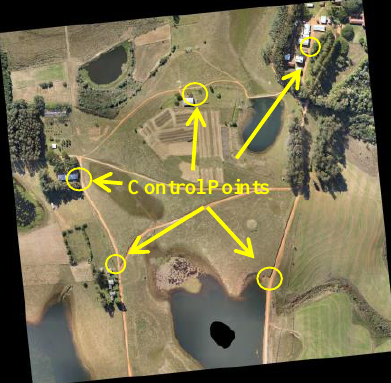
Figure 8. Pre-processing for identification of control points and check points.